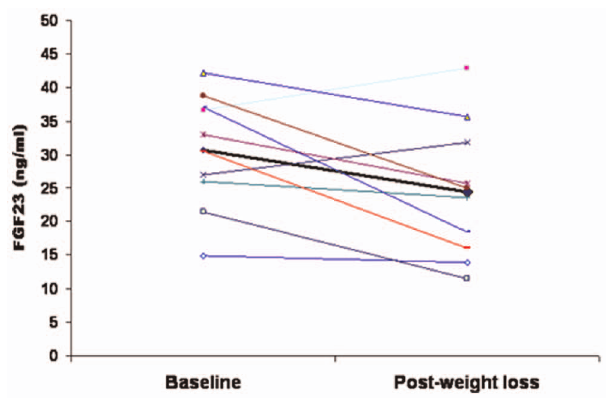
Figure 4. Individual changes in serum intact FGF-23 concen- trations in obese subjects after weight loss.